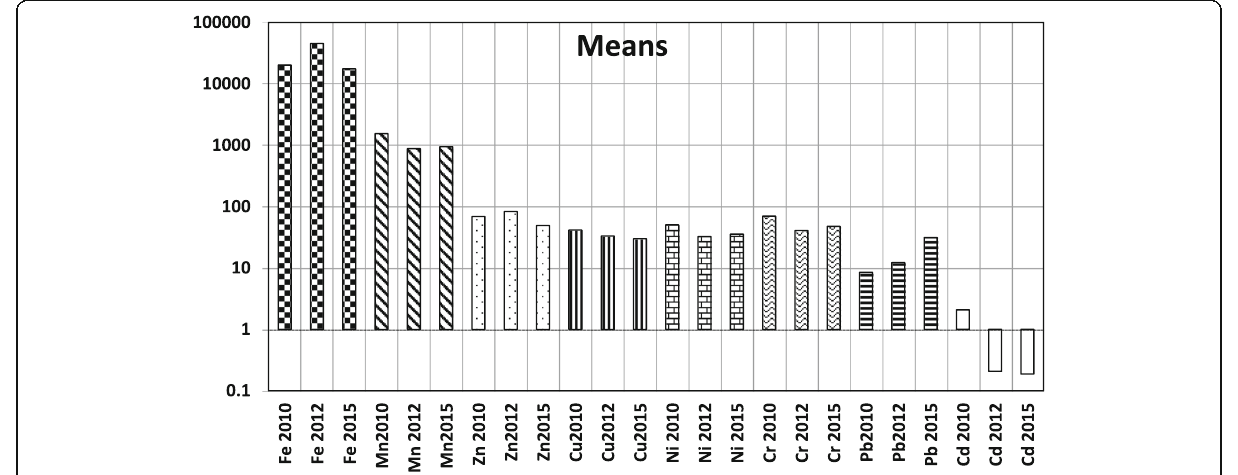
Fig. 3 Means of heavy metals in different stations. a Means of heavy metals of EL-Burullus Lagoon during periods of 2010, 2012 and 2015. b Results show the comparison between the mean concentrations of each heavy metal in bottom sediments through different 3